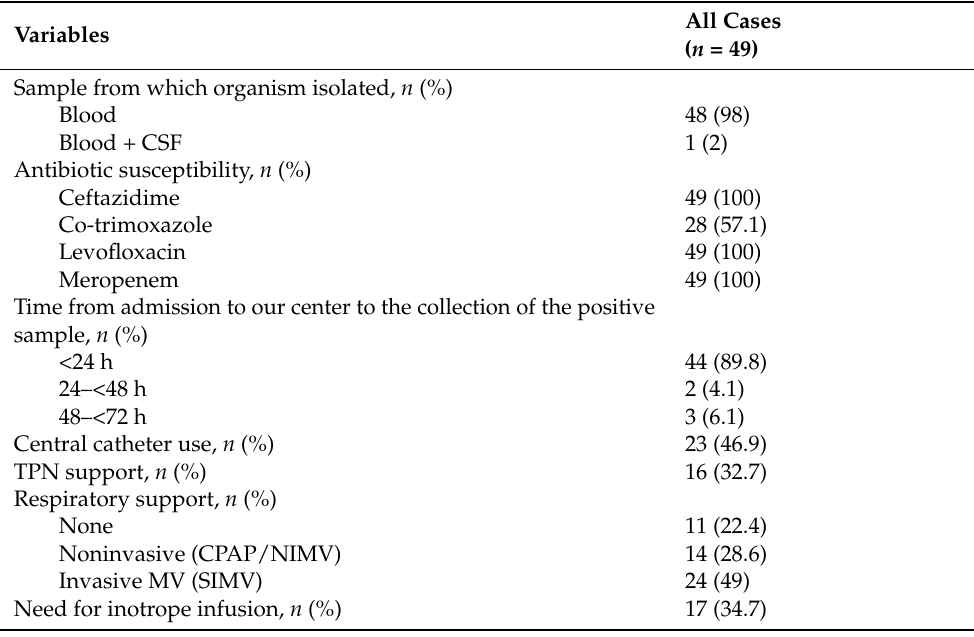
Table 2. Microbiological characteristics, laboratory values, clinical profile during the infection, and outcomes of the neonates with Burkholderia cepacia complex